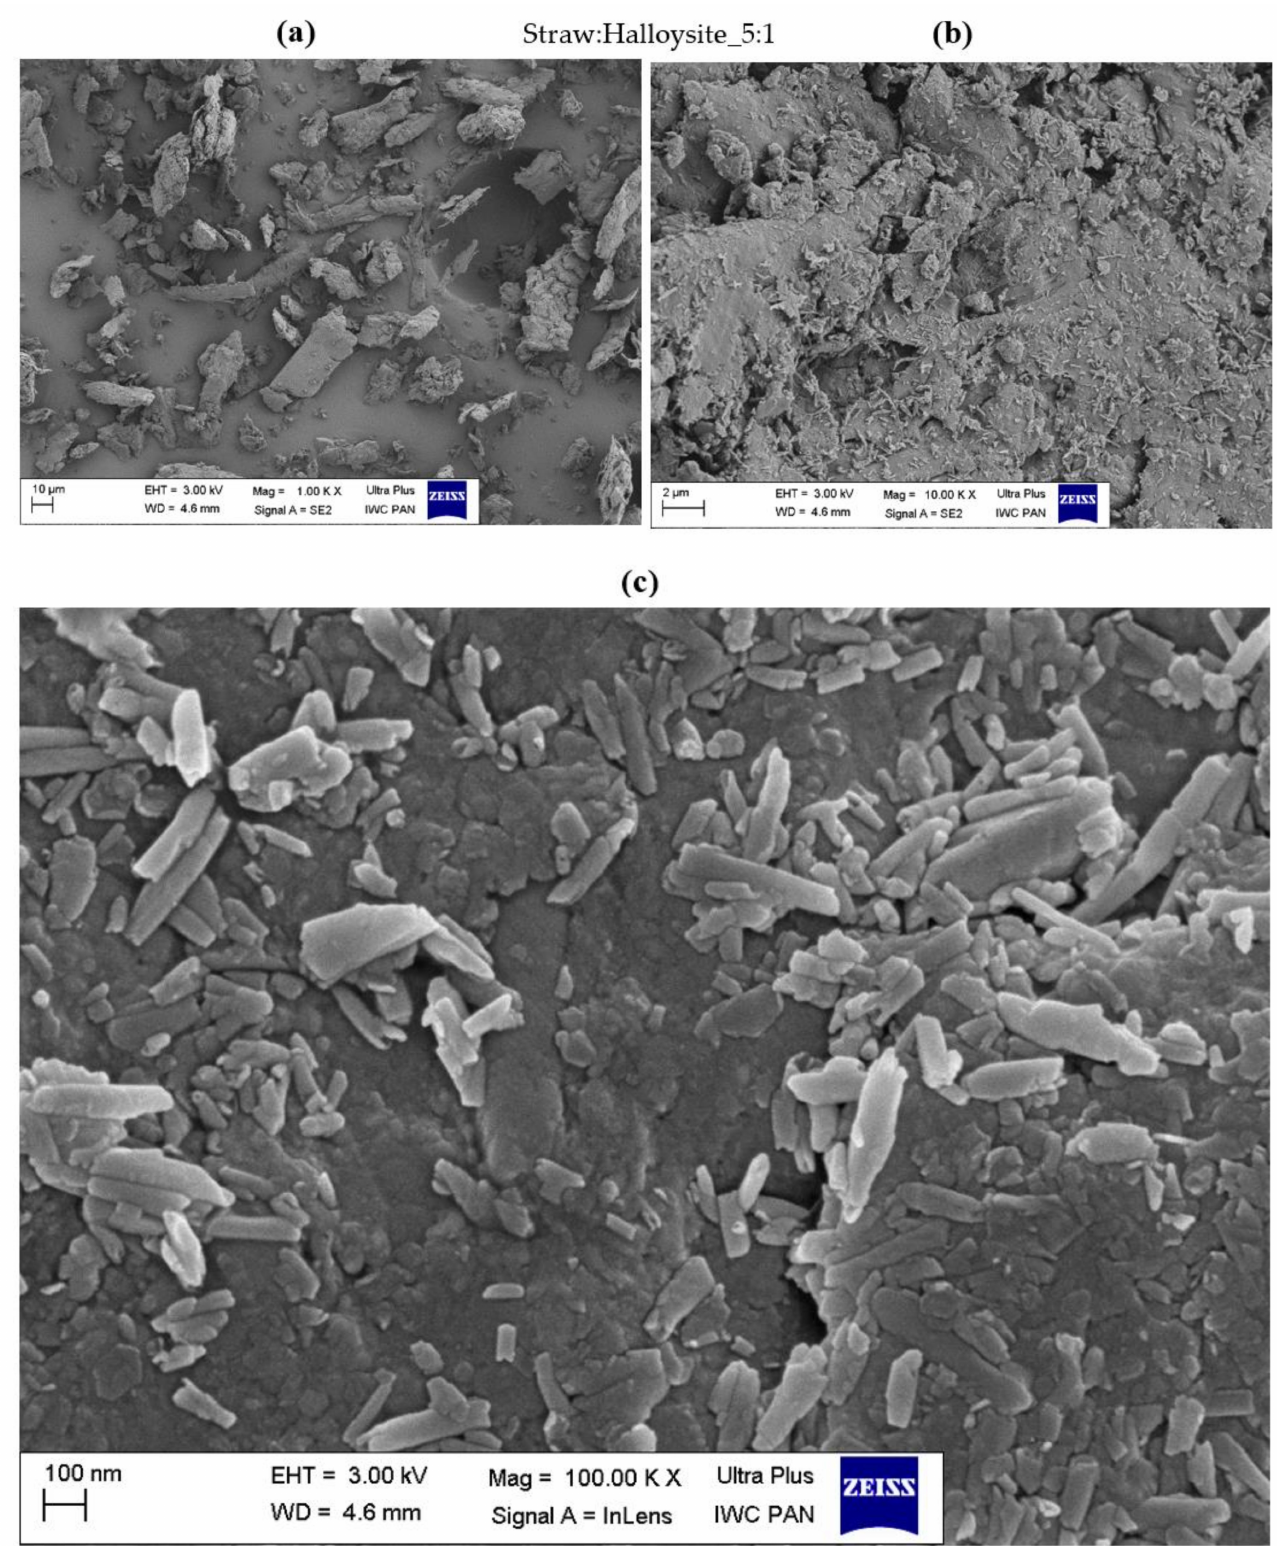
Figure 5. Microscopic images of straw fillers with the addition of halloysite nanotubes (5:1) at a magnification of ( a ) × 1.00 k, ( b ) × 10.000 k, ( c ) × 100.00